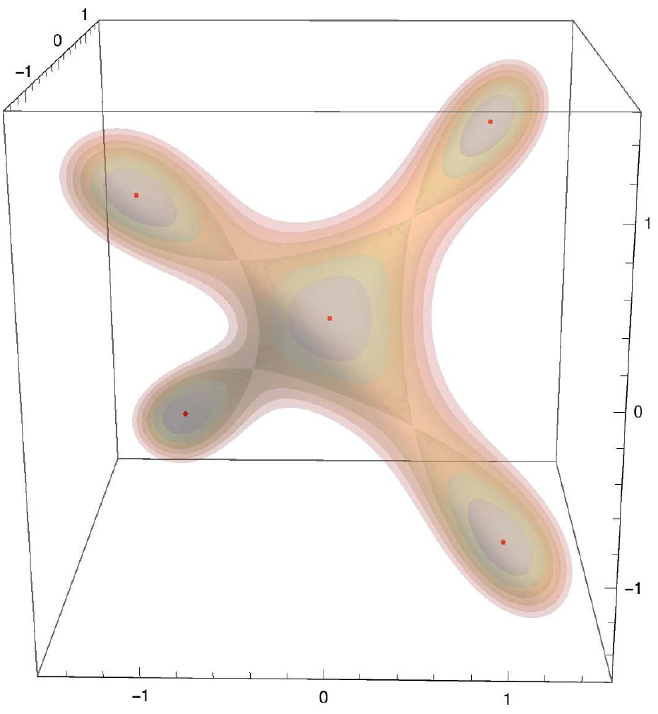
Figure 1 . Contours of the Newtonian potential V in